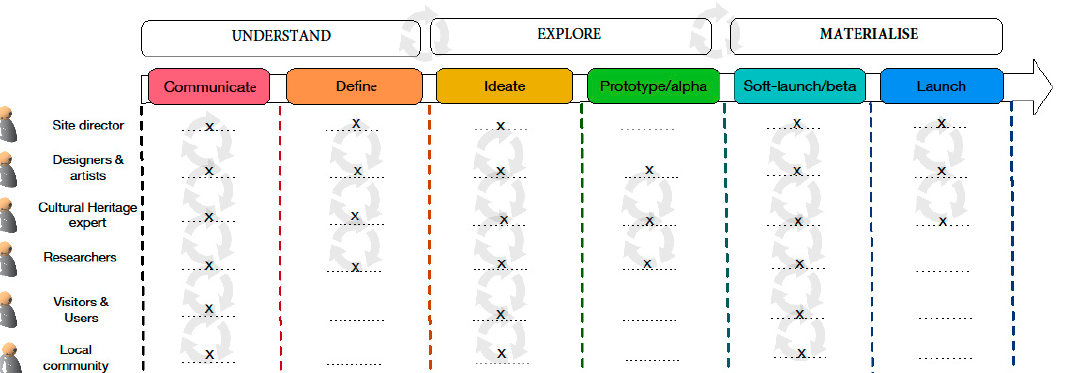
Figure 5. Framework for participative development of digital cultural heritage. Grey arrows signify collaboration and feedback between stages. Understanding the problem first involves communication among all the stakeholders with the objective of defining the design challenge from various perspectives. Using this definition, all stakeholders meet again to ideate a concept intervention, which is prototyped by the designers, CH experts, and researchers. The product is iterated with feedback from all stakeholders before it is finally launched.